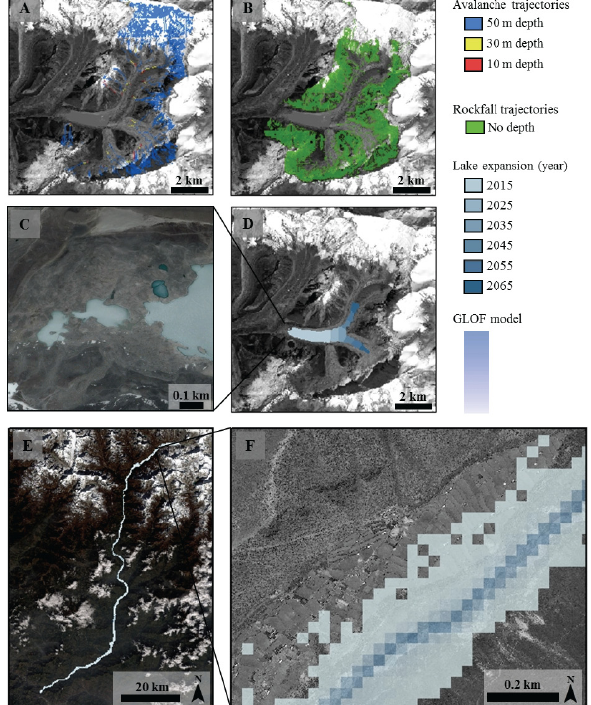
Figure 7. Hazards and downstream impact for Imja Tsho: (a) avalanche trajectories, (b) rockfall trajectories, (c) ponds on the moraine, (d) future lake expansion, and (e) the extent of the MC- LCP GLOF model (f) highlighting the impacts at Dingboche. The background image (a–e) is Landsat 8 from 30 September 2015 and (f) WorldView 2 from 7 June 2015 (DigitalGlobe,